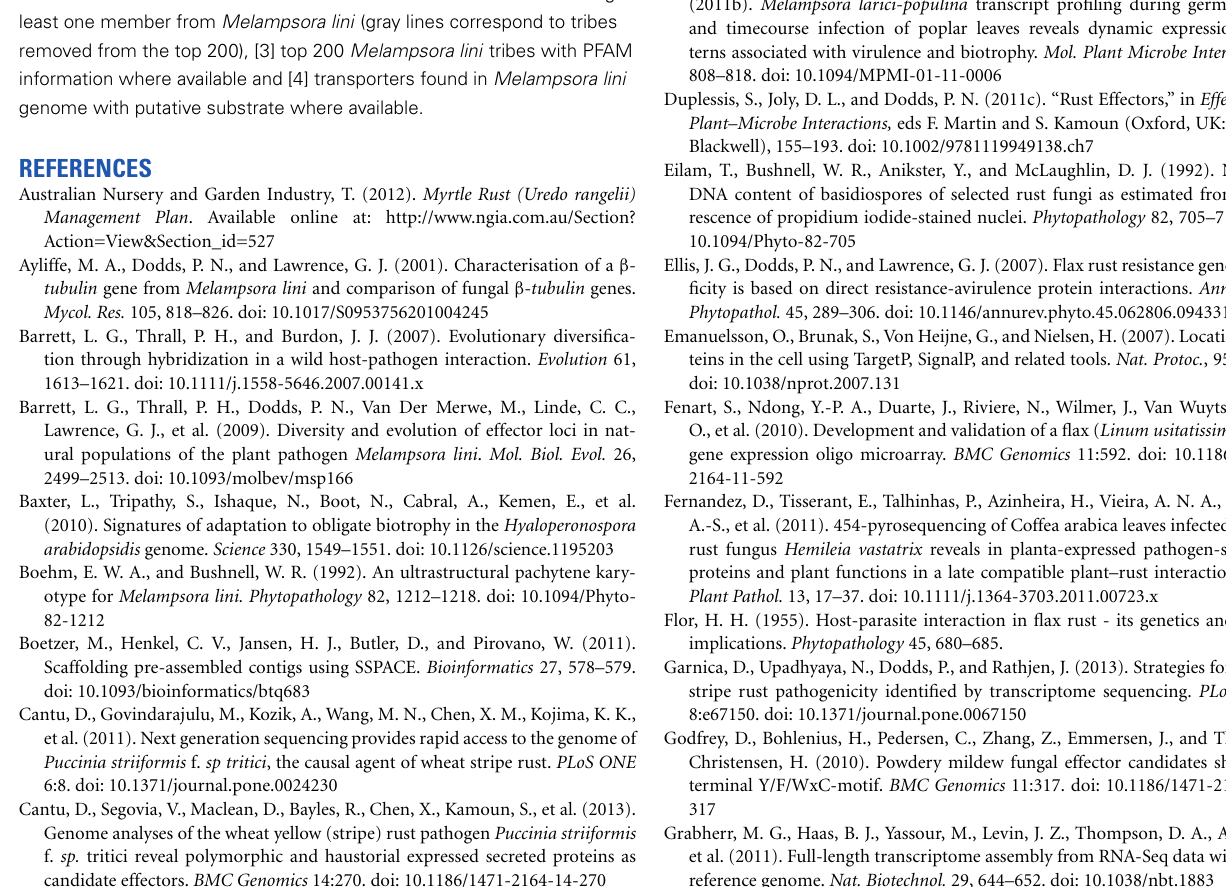
Table S1 | Libraries used for the assembly of the genome and infection transcriptome of the flax rust pathogen Melampsora lini isolate CH5. Additional file 1 | (.zip) Fasta files of M. lini genomic scaffolds